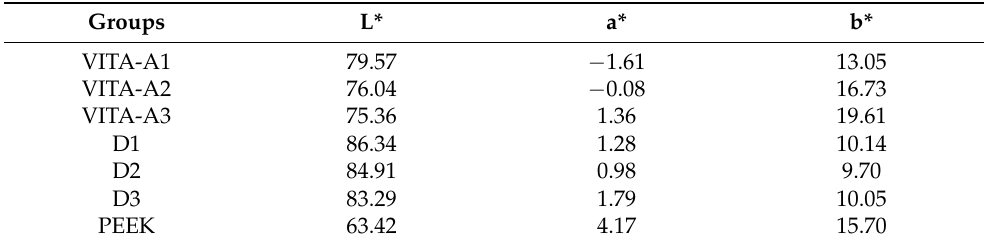
Table 5. Color coordinates of VITA A1–A3 and white PEEK specimens.